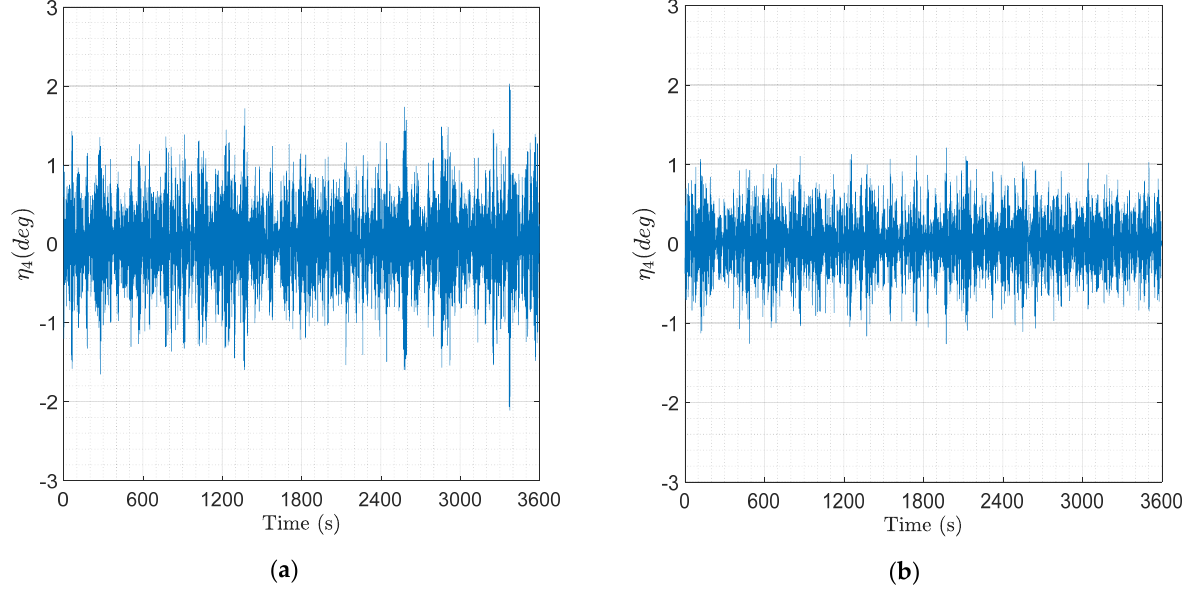
Figure 11. Data collection, roll amplitude: ( a ) 7 January 2020; ( b ) 8 January 2020.